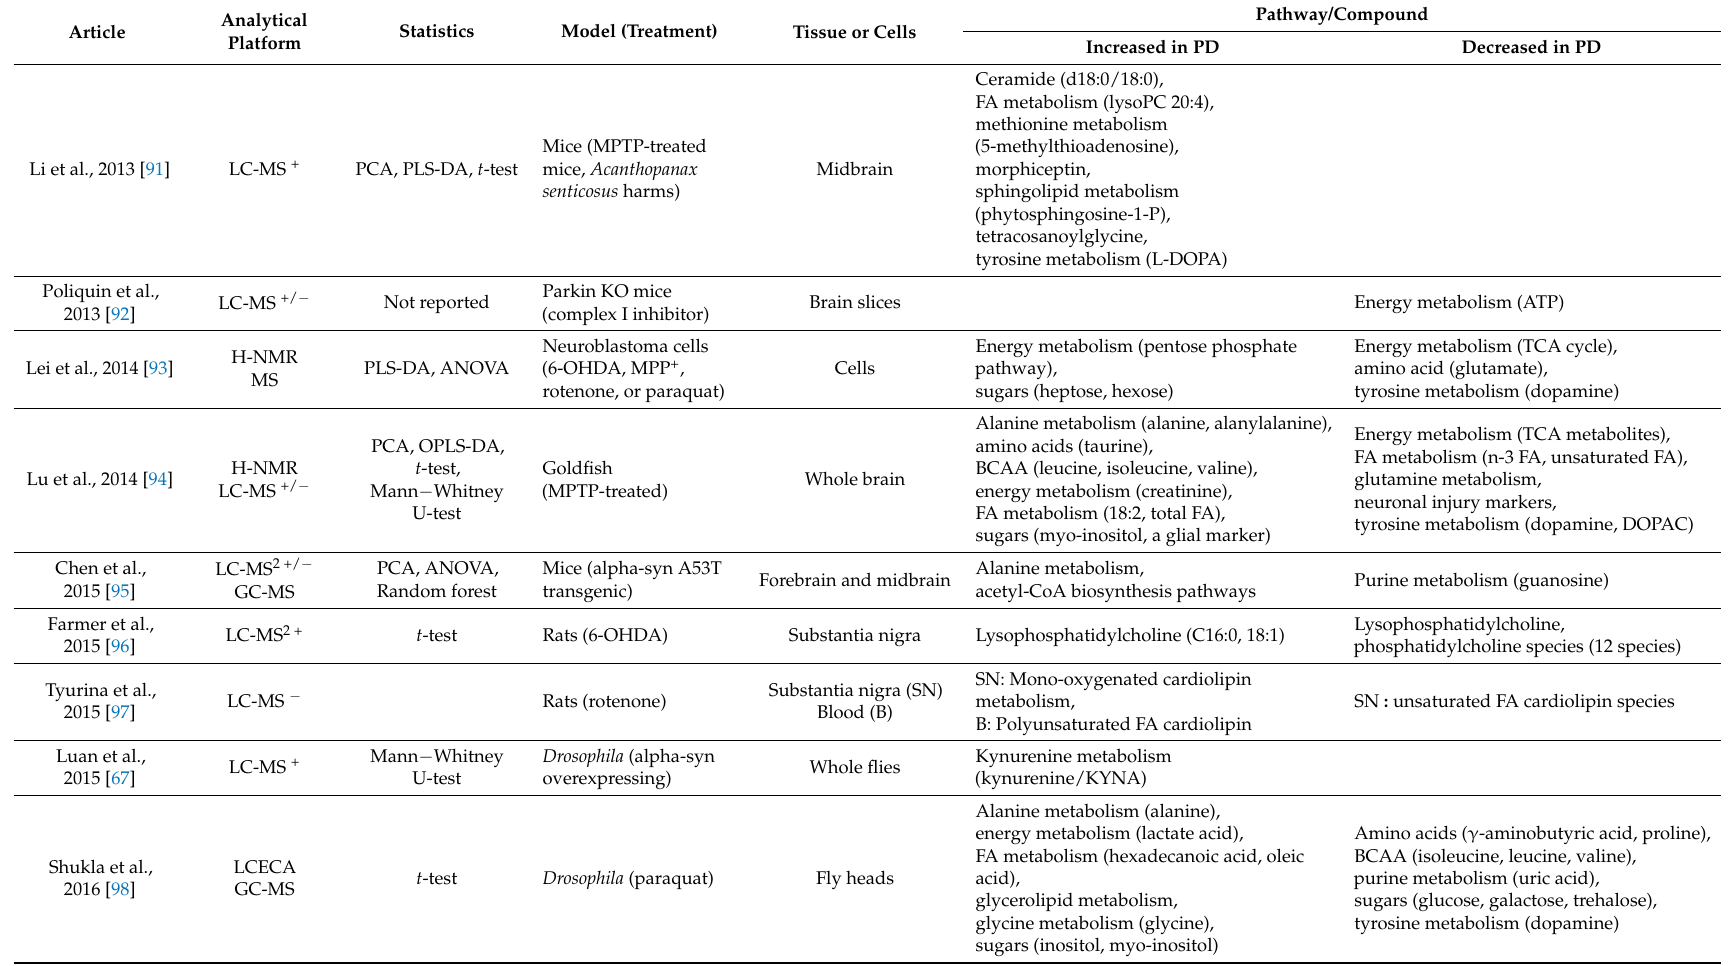
Table 2. Overview of metabolomic studies in PD model organisms. DOPAC, dihydroxyphenylacetic